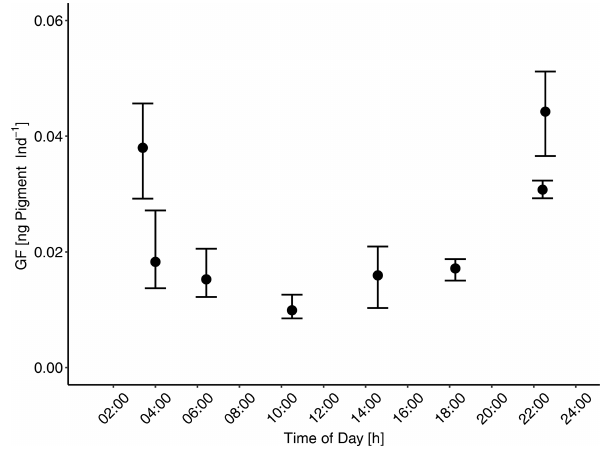
Figure 2. Gut fluorescence [ngpigmentInd − 1 ]: diel feeding rhythm to determine time of maximum gut fullness of adult female Para- calanus sp. Gut fluorescence was analyzed on females collected over a 24h cycle in the mesocosms. Maximum gut fullness was de- tected early in the morning (03:44) and 1h before midnight (22:55). Error bars depict 95% confidence